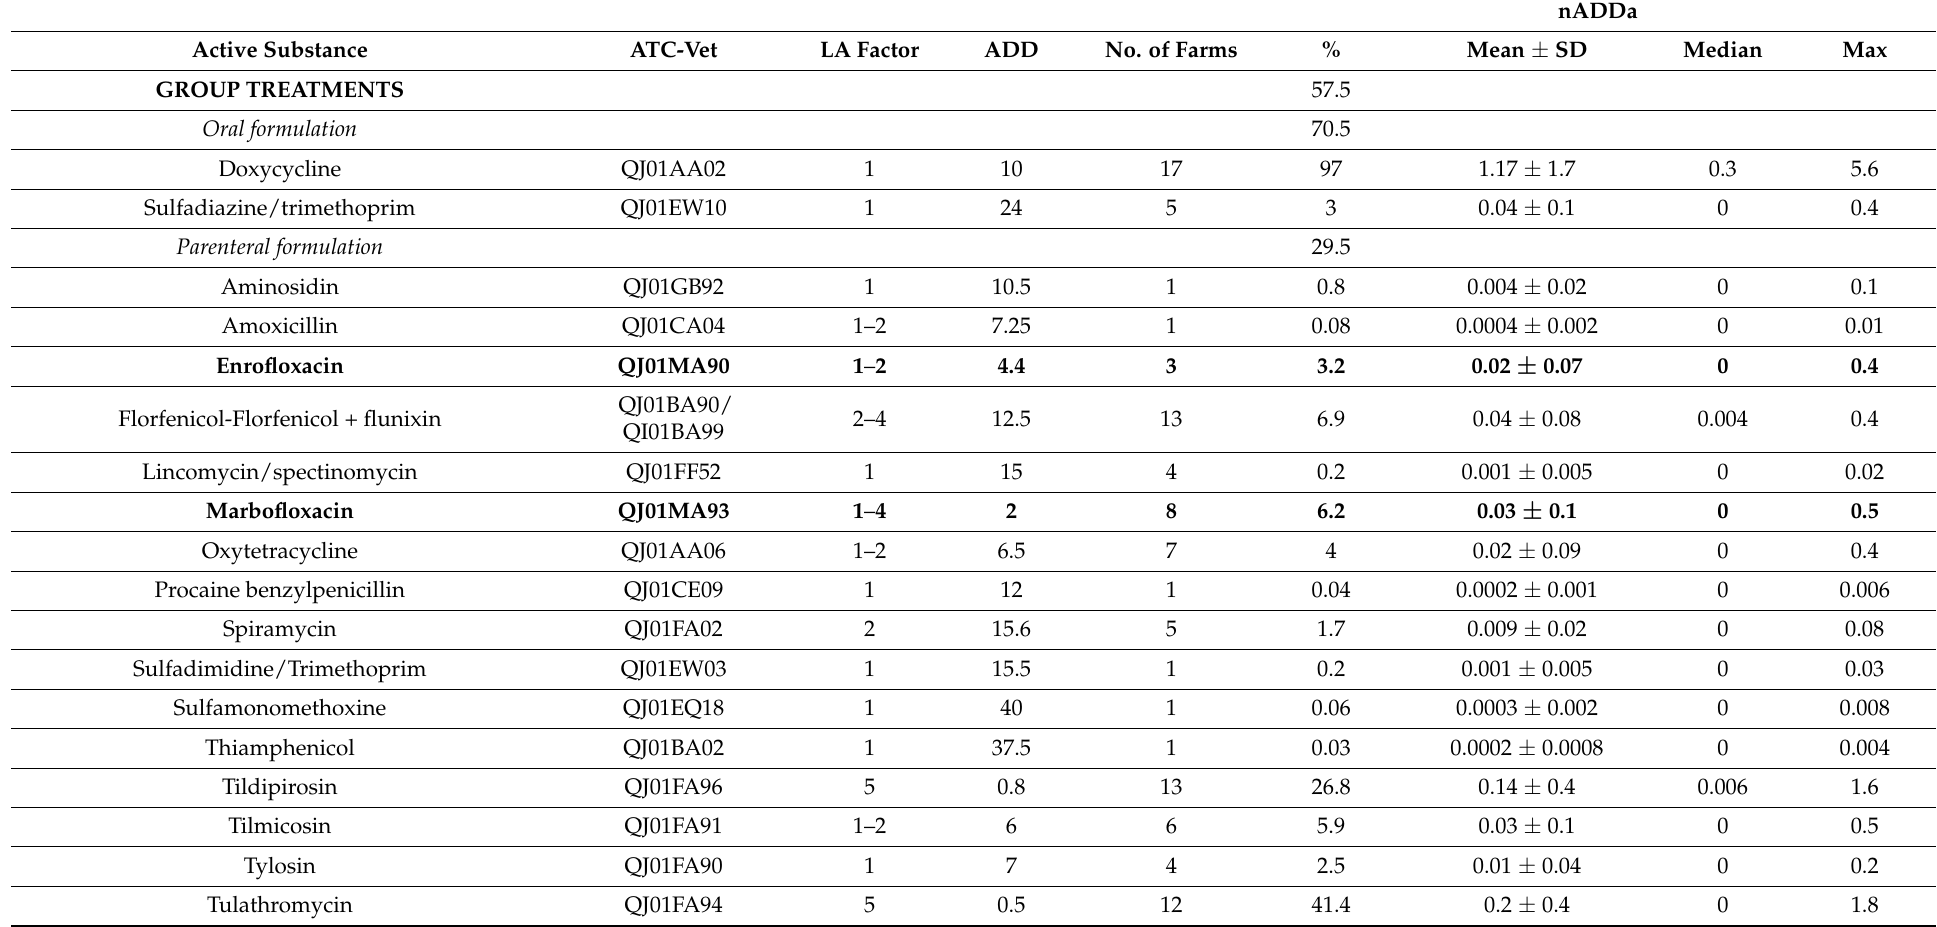
Table 4. Distribution, mean ± SD, median and maximum nADDa administered per year in 2014 and 2015. Data from 26 fattening operations located in northwestern Italy are reported by active substance group and individual treatments and route of administration (oral, parenteral), and number of farms, The long-acting (LA) factors and the final ADD (mg/kg) used for the analysis are also reported. Percentage of oral and parenteral formulation refers to the type of treatment (“group” vs. “individual”), while percentage of active compounds refers to the type of formulation (“oral” vs. ”parenteral”). In bold are the highest priority critically important antimicrobials (HPCIA) in category B according to the European Medicine Agency